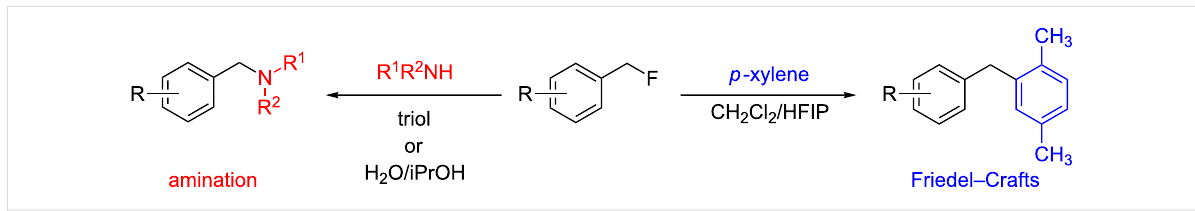
Figure 1: C–F activation of benzylic fluorides to generate benzylamine or diarylmethane products.